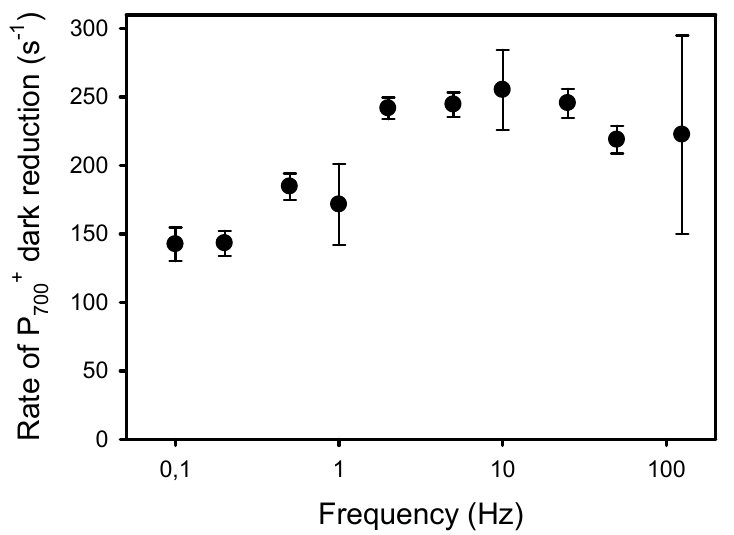
Figure 8. Apparent rate constant (k) of the P 700+ dark reduction occurring at the end of the light pulses given at different